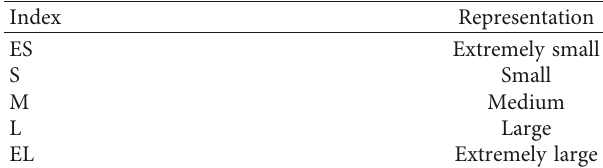
Table 1: Linguistic